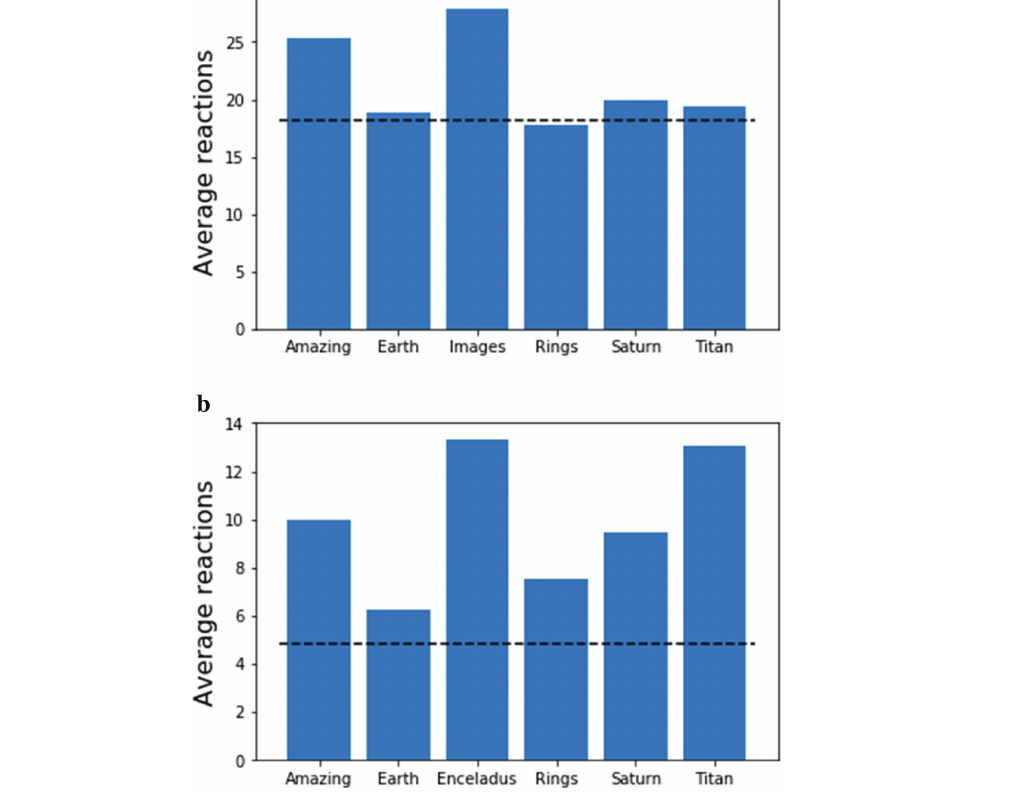
Figure 11. The average number of reactions for comments relating to the Cassini mission, from (a) news articles; (b) YouTube videos. Also shown is the average number of reactions across all comments (Source: Authors,